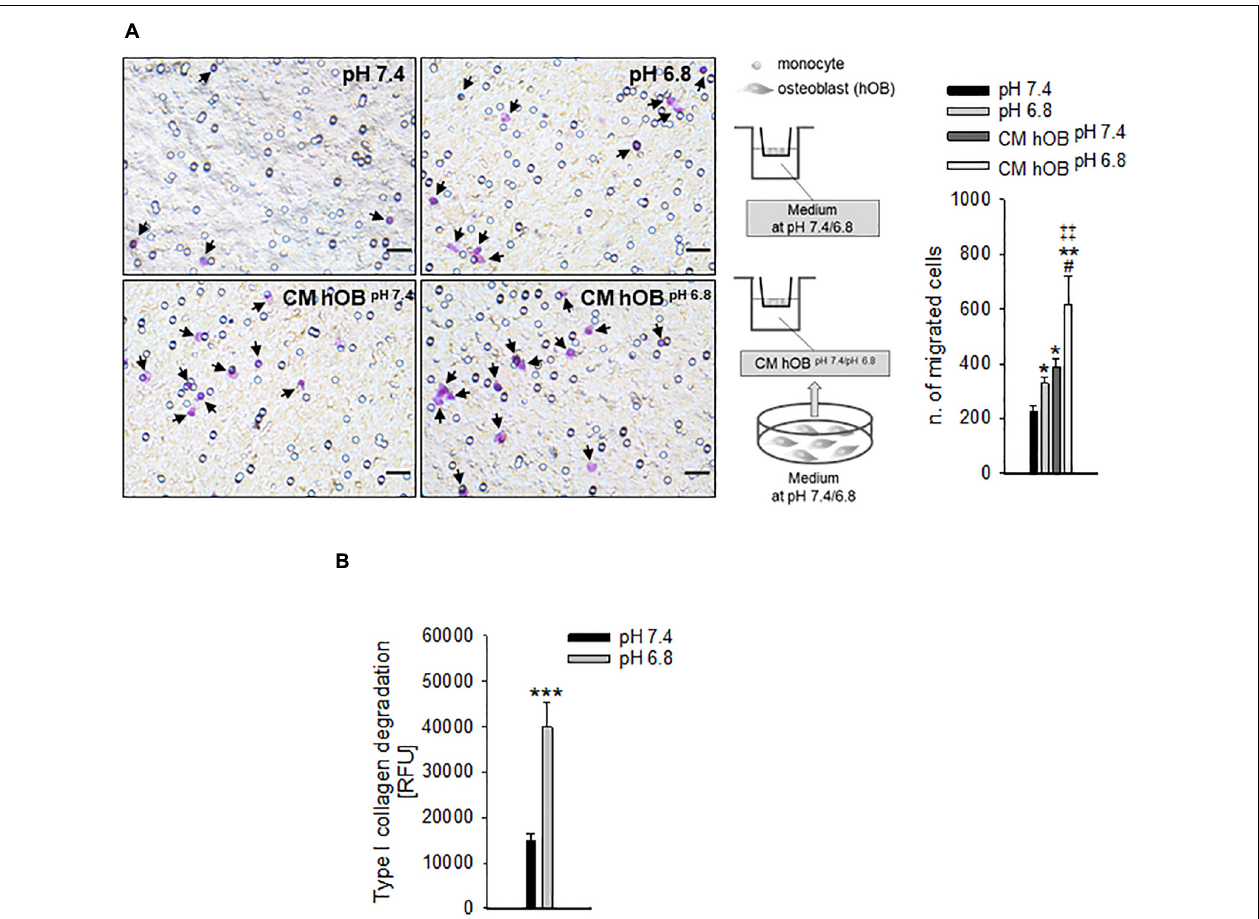
FIGURE 3 | The recruitment of OC precursors and the activity of OC are enhanced by extracellular acidosis via different mechanisms. (A) CD14 + cells were seeded on the upper compartment of a Transwell system, and acidic or neutral medium (pH 6.8 and pH 7.4, respectively), or the conditioned medium of hOB treated or not treated with acidic medium (CM hOB pH 6 · 8 and CM hOB pH 7 · 4 , respectively) were added to the lower compartment; after 36 h of exposure to the specific chemotactic stimulus, migrated cells were counted. On the left, representative images of CD14 + migrated cells stained with crystal violet (black arrows), scale bar 25 µ m; on the right, scheme of the experiment and graph of the counted migrated cells, mean ± SEM ( n = 6, * p < 0.05 and ** p < 0.01 vs. pH 7.4, # p < 0.05 vs. CM hOB pH 7 · 4 , ‡‡ p < 0.01 vs. pH 6.8). (B) Type I collagen degradation activity of differentiated OC at acidic versus neutral condition, mean ± SEM ( n = 8, ** *p < 0.001).